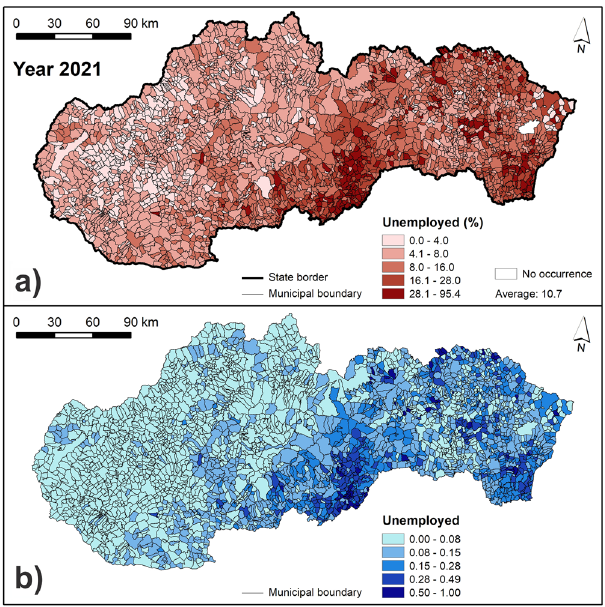
Figure 10. Indicator of the share of unemployed persons from the total number of economically active population: ( a ) original values; ( b ) normalized values. This figure was generated in ArcGIS 10.2.2 software.